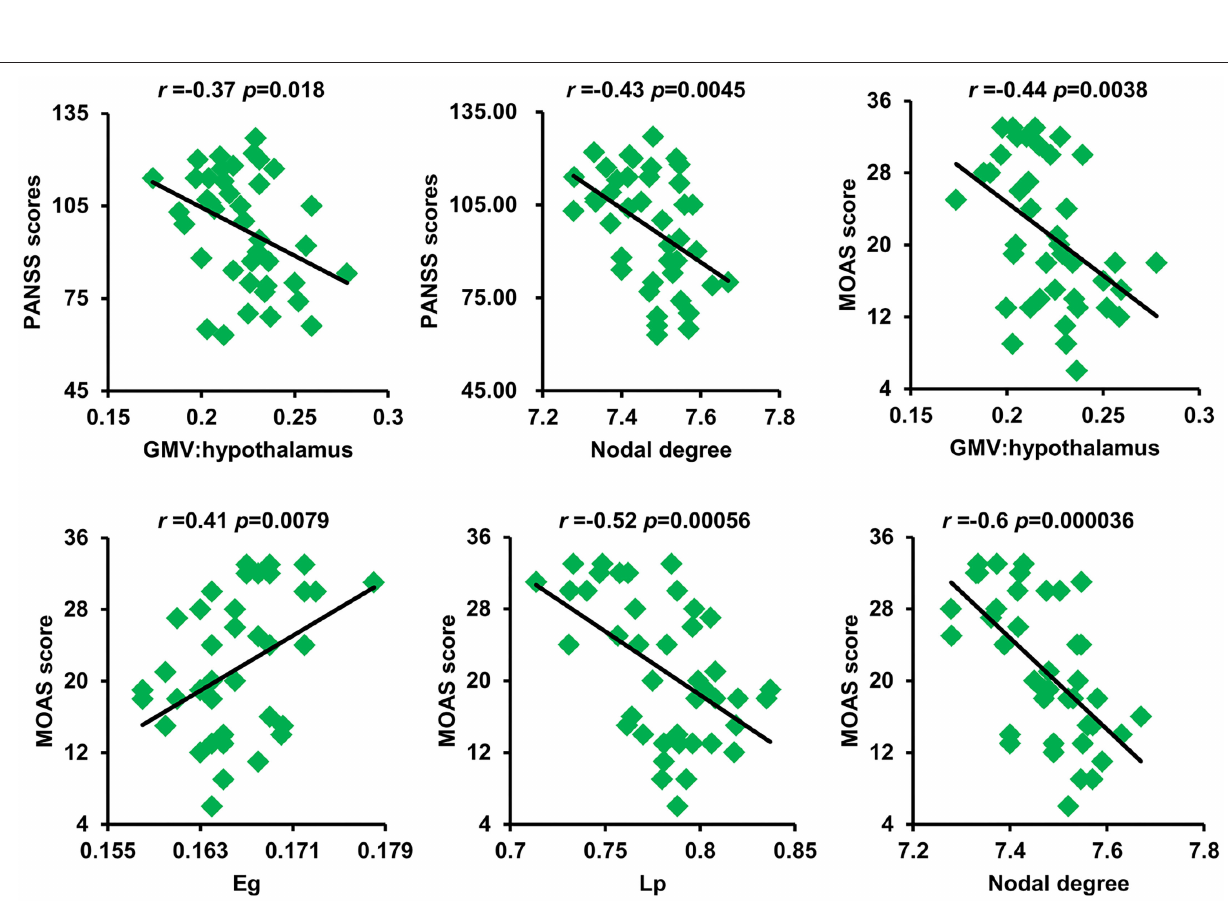
FIGURE 4 | Significant correlations between GM volume of the hypothalamus and nodal degree and PANSS scores as well as between GM volume of the hypothalamus and Eg, Lp, nodal degree, and MOAS scores were found. GM, gray matter; PANSS, Positive and Negative Syndrome Scale; Eg, global efficiency; Lp, shortest path length; MOAS, modified overt aggression